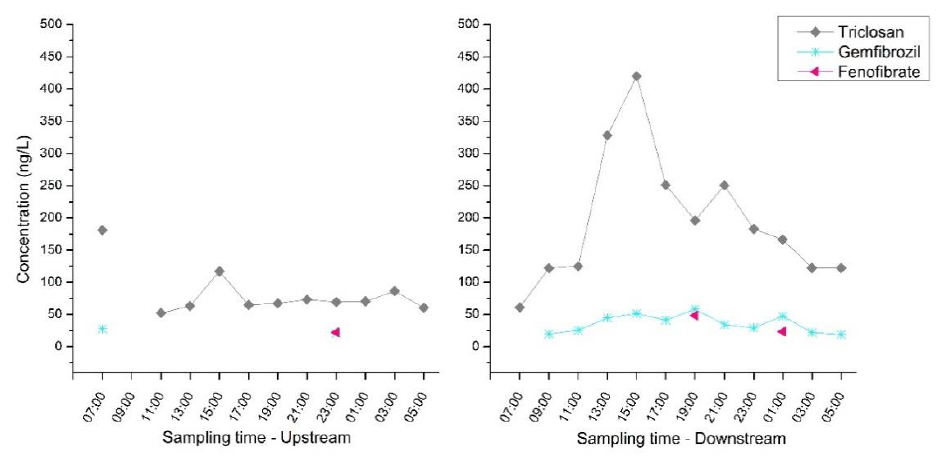
Figure 2. Daily variation of triclosan, gemfibrozil and fenofibrate.